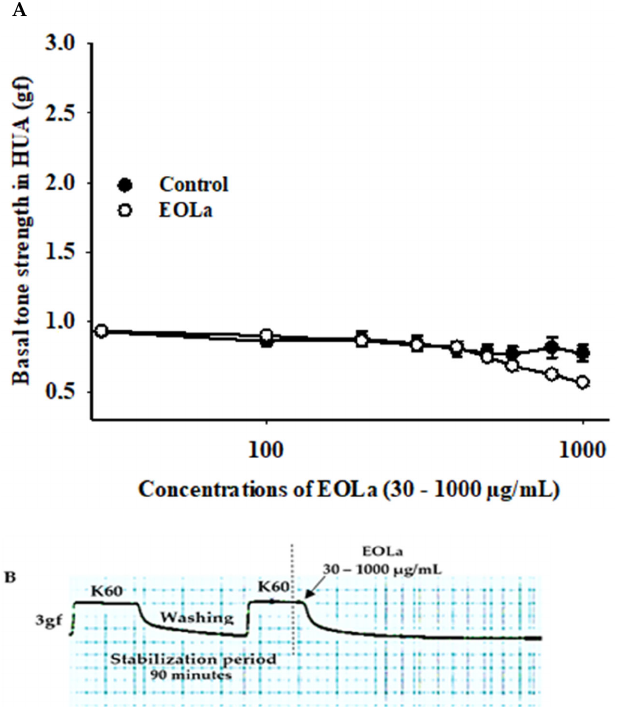
Figure 1. Effect of EOLa on basal vascular tone in HUA. ( A ) “Log-normal” plot for the effect of EOLa (30–1000 μ g/mL) on basal HUA tone. The values are expressed as the mean ± SEM; n = 6 ( p < 0.001, one ‐ way ANOVA). ( B ) Original register in LabChart Pro software for relaxant effect of EOLa on vascular basal tone in HUA. 2.2. Relaxant Effect of EOLa on Contractions Induced by KCl (60 mM), 5 ‐ HT (10 μ M), and HIST (10 μ M) in HUA.